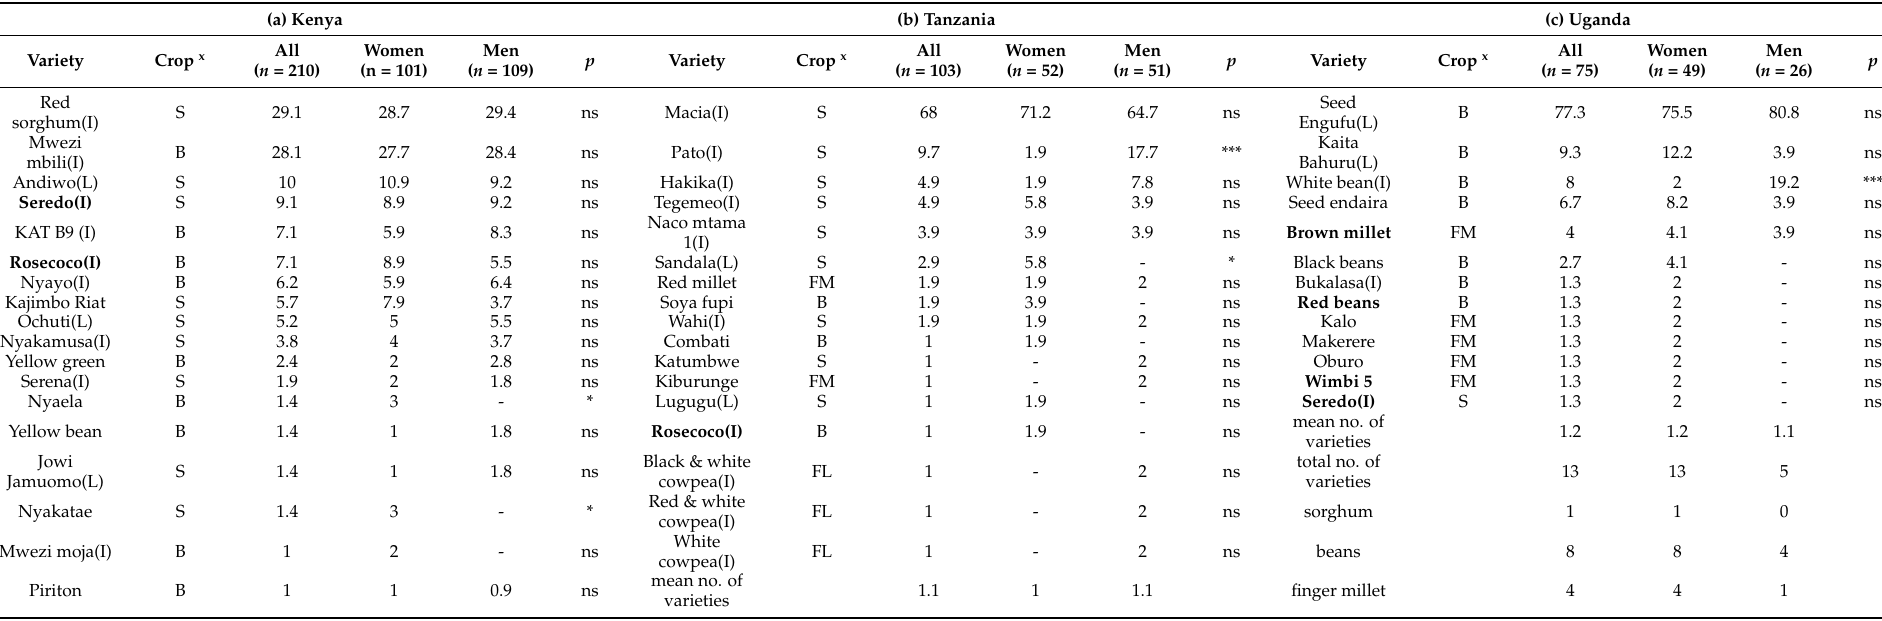
Table A2. (a–c): Proportion of men and women who mentioned specific varieties they use to cope with climate change, by country and crop (% of respondents). (a) Kenya (b) Tanzania (c)